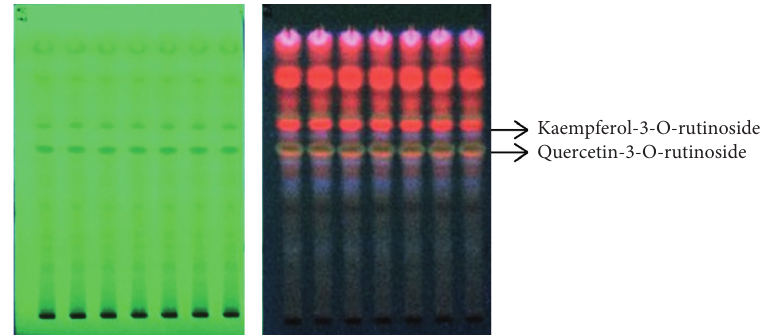
Figure 5: Thin-layer chromatogram of the ethyl acetate fraction as shown by a TLC scanner (254 and 366 nm), developed in toluene :ethyl acetate:formic acid (5:4 :1, v/v/v).